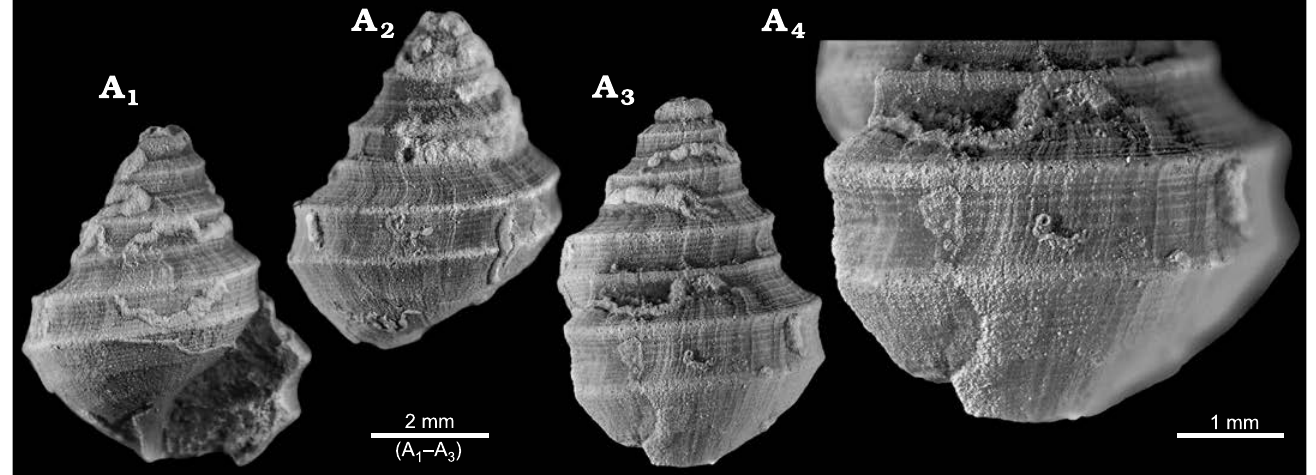
Fig. 5. Trochonematid gastropod Eunema badioticum Kittl, 1891, PZO 12796, from Lago Antorno, northern Italy, Cassian Formation, Carnian, Upper Triassic. In apertural (A 1 ) and lateral (A 2 , A 3 ) views; A 4 , detail of last whorl showing fine ornamentation including pits on upper angulation, in lateral